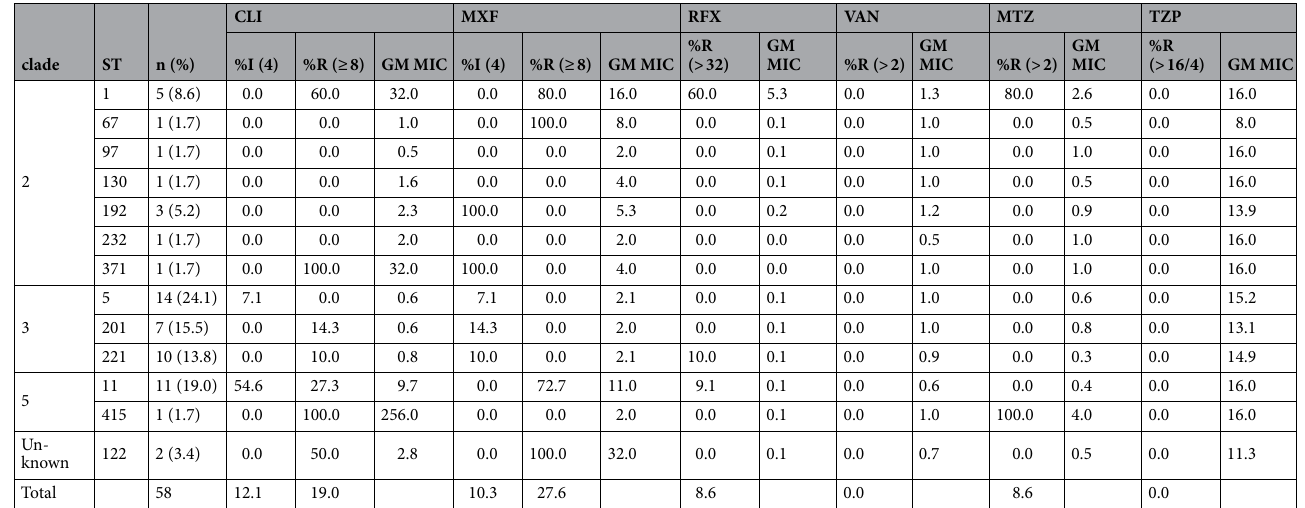
Table 1. Antimicrobial susceptibility and geometric mean minimum inhibitory concentrations (µg/mL) of binary toxin–positive Clostridioides difficile isolates, 2009–2018. CLI , clindamycin; GM MIC , geometric